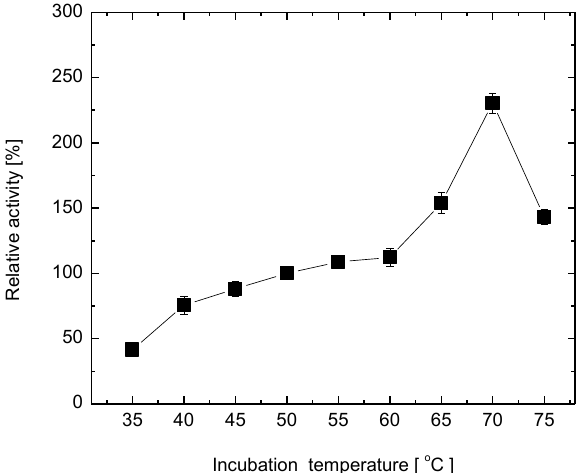
Figure 10. Effect of different temperatures on partial purified dextranse